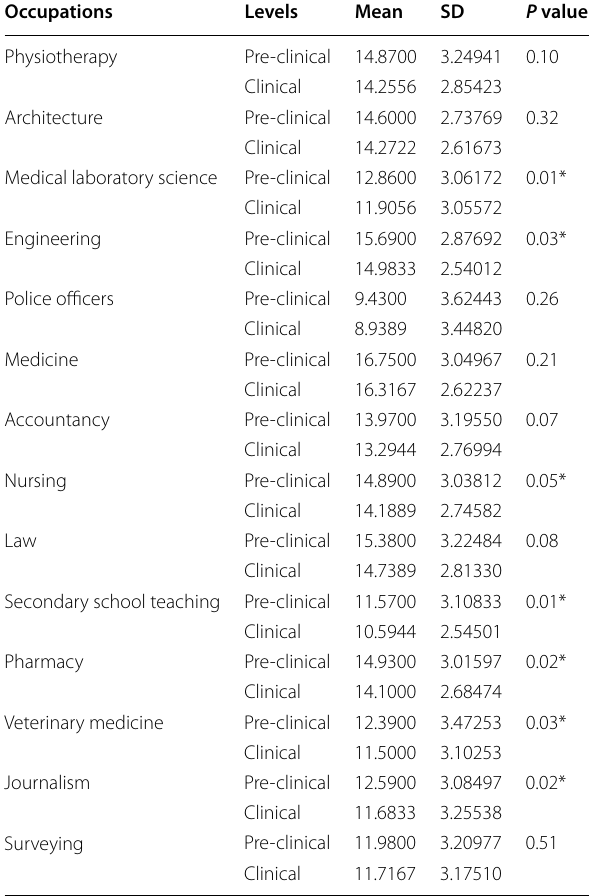
Table 3 Pre-clinical and clinical students’ perception of